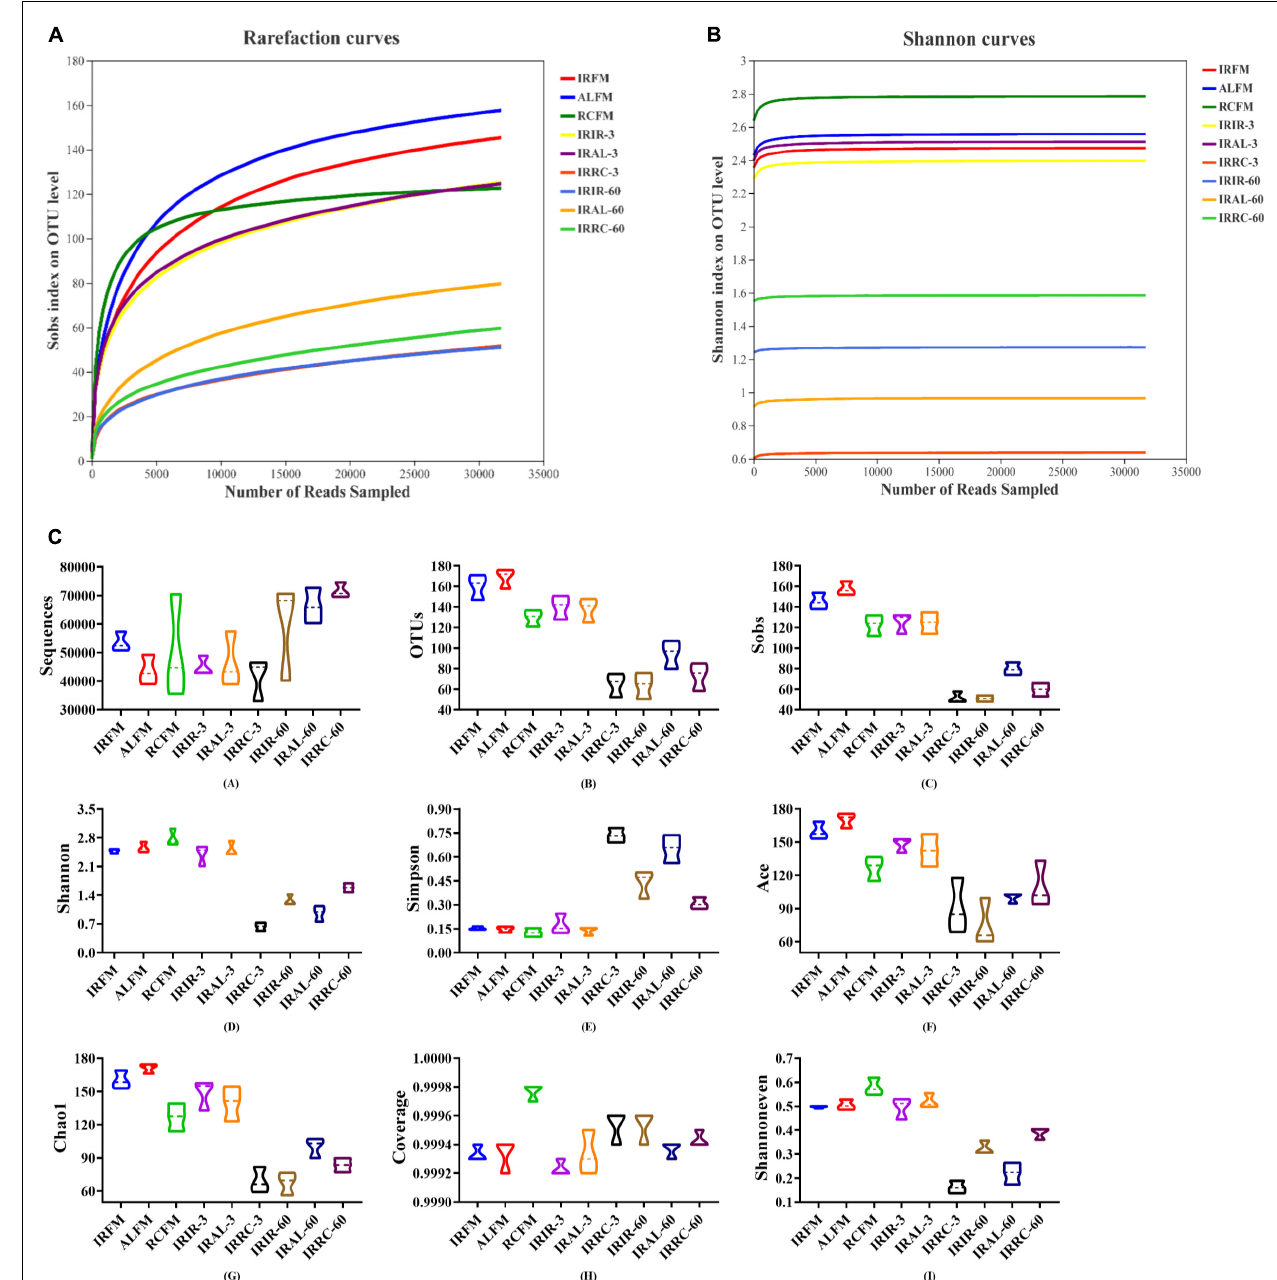
FIGURE 1 | Richness and diversity indices of bacterial communities in fresh materials and Italian ryegrass silages during ensiling. (A) Rarefaction curves. (B) Shannon curves. (C) Richness and diversity indices of bacterial communities. IRFM, fresh material of Italian ryegrass; ALFM, fresh material of alfalfa; RCFM, fresh material of red clover; IRIR, sterile Italian ryegrass inoculated by epiphytic bacteria from Italian ryegrass; IRAL, sterile Italian ryegrass inoculated by epiphytic bacteria from alfalfa; IRRC, sterile Italian ryegrass inoculated by epiphytic bacteria from red clover; 3, 3 days of ensiling; 60, 60 days of